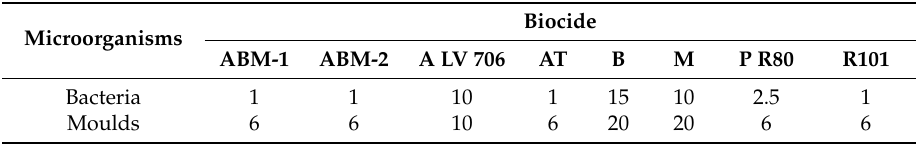
Table 2. Concentrations of biocides (%, v / v ) where growth inhibition zone ≥ 10 mm in diameter was observed.